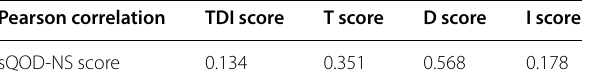
score and TDI score using Pearson’s correlation coefficient test ( T , threshold; D , discrimination; I ,